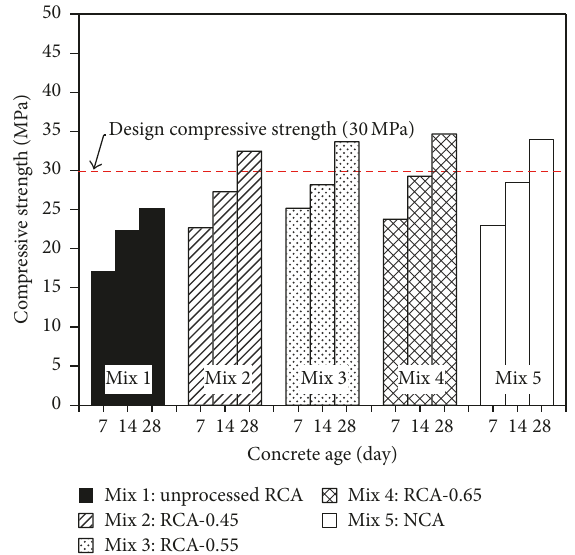
Figure 11: The variations of compressive strength of concrete cylinder made of different coarse aggregates with concrete